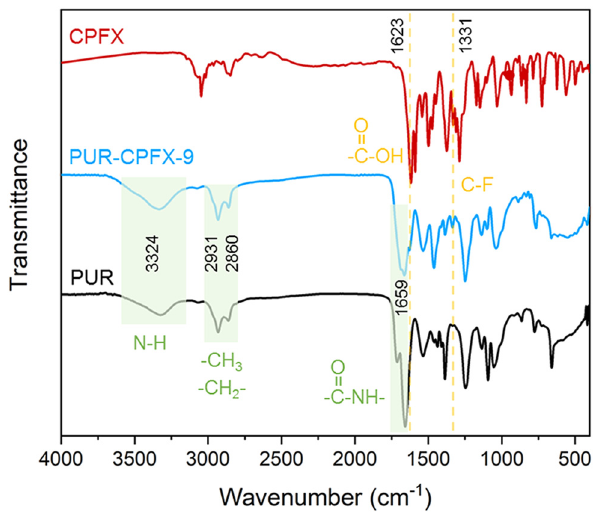
Figure 1: FTIR spectra of CPFX, PUR - CPFX - 9, and PUR.